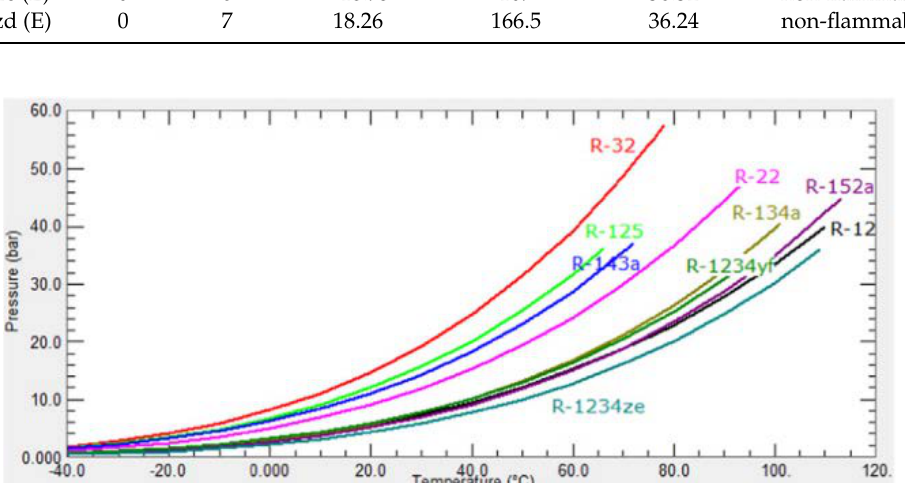
Figure 2. Critical temperatures and pressures of synthetic refrigerants [41]. Reproduced with permission from [Elsevier], Elsevier, 2020.